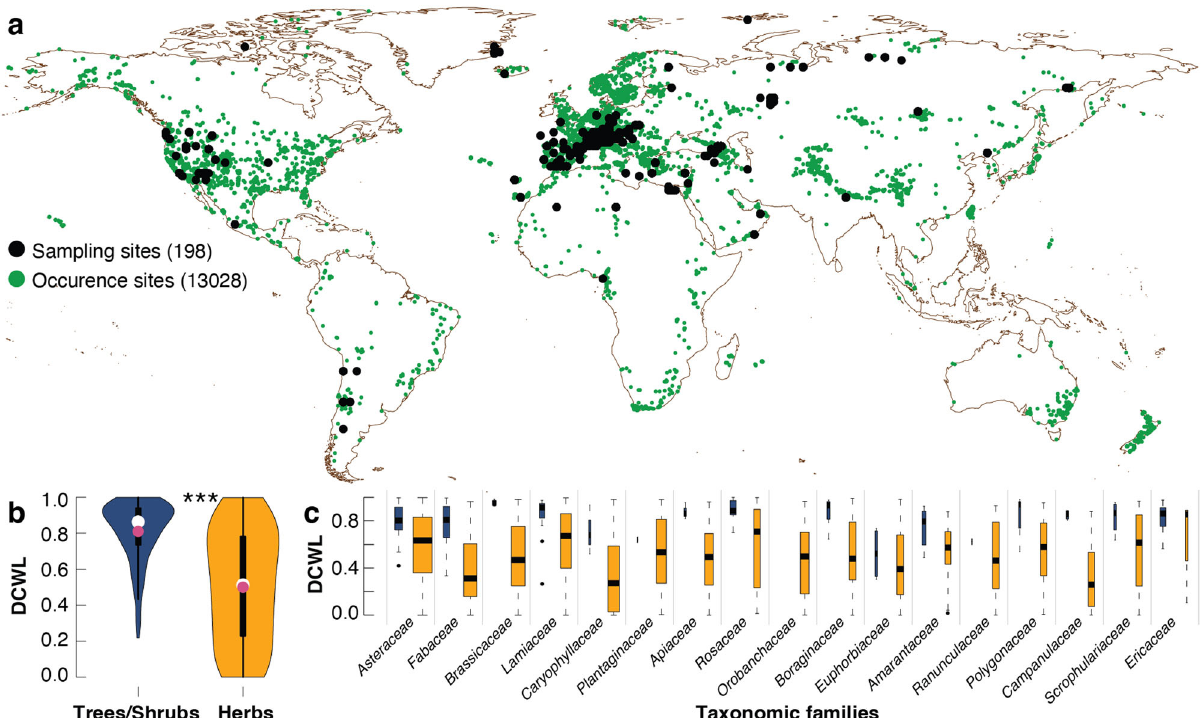
Fig. 3 Global dataset of plant cell wall ligni fi cation. a Black dots show the location of the 198 sampling sites on six continents between 40°S and 80°N, and between sea level and around 6150 m asl, superimposed on corresponding species ’ occurrence data (green dots) obtained from the Global Biodiversity Information Facility (GBIF) 51 . b Violin plots describe the distribution of DCWL in trees and shrubs (dark blue), as well as in herbs (herbaceous dicots; orange), which ranges from 0 to 1 (from almost un-ligni fi ed to almost completely ligni fi ed). The shape of the violin plot refers to the proportion of data. Black boxes within each violin show the interquartile range and whiskers the 95% con fi dence intervals. Red is the mean and white dot is the median of the data. Three asterisks (***) indicate signi fi cant ( p < 0.001) differences of a paired-sample t -test between the mean DCWL in trees/shrubs and herbs (scores for trees and shrubs: mean = 0.81, standard deviation = 0.17 and for herbs: mean = 0.50, standard deviation = 0.31; t (25.7) = 1115.1). c Box and whisker plot of DCWL of the 17 plant families with more than 25 species split into trees and shrubs (dark blue), as well as herbs (orange). Box width is proportional to the number of species, box length indicates the interquartile range, whiskers the 5th and 95th percentiles, and horizontal black lines the